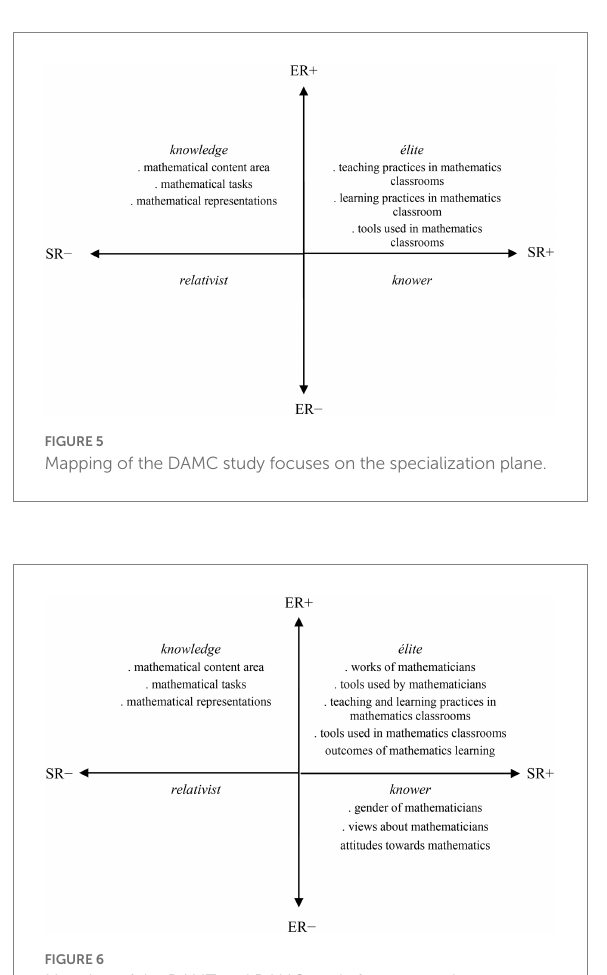
FIGURE 6 Mapping of the DAMT and DAMC study focuses on the specialization